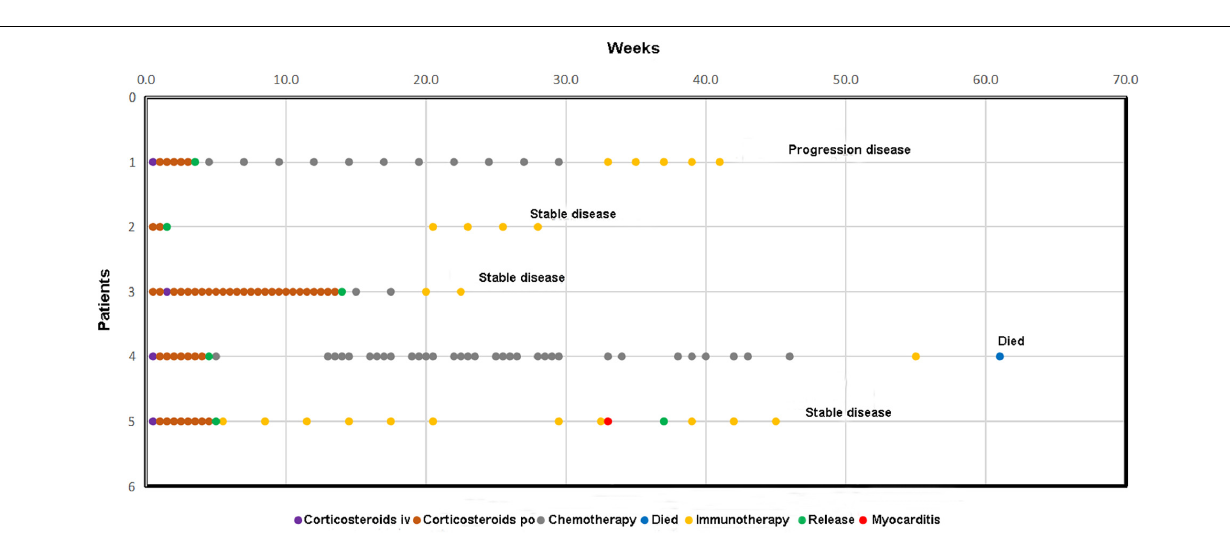
FIGURE 6 | Follow-up of patients who restart ICI therapy after suffering ICI-related cardiotoxicity.